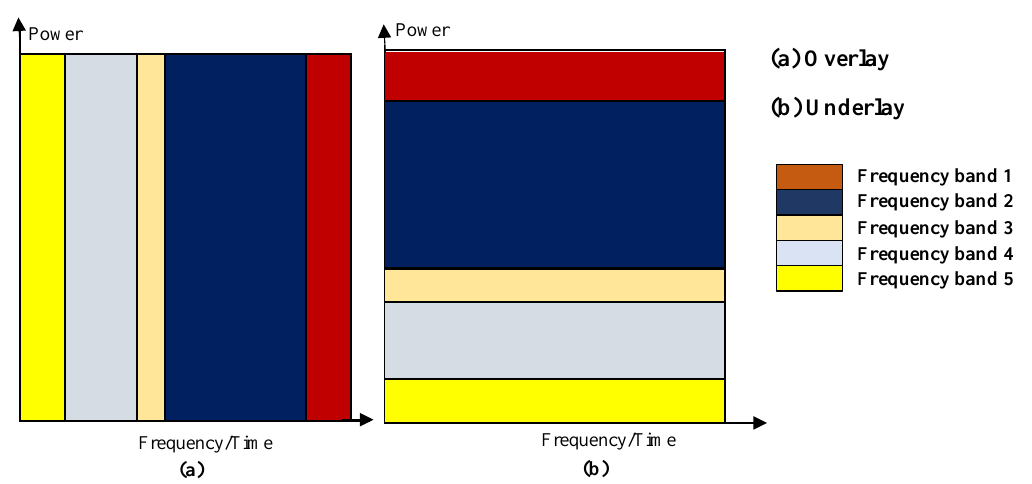
Figure 1. Overlay versus underlay spectrum sharing